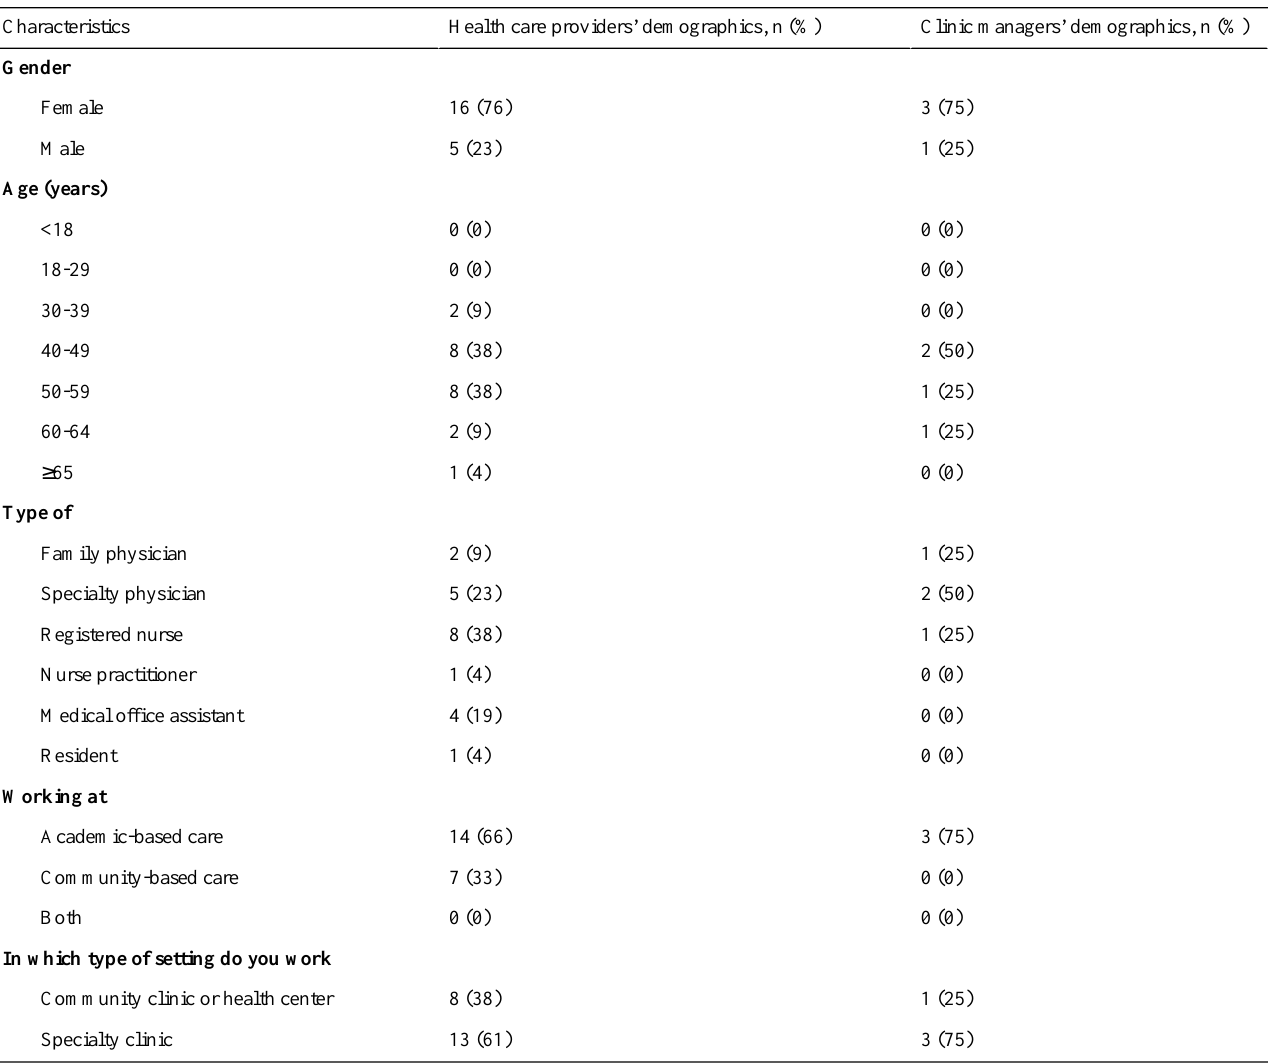
Table 3. Demographic information of the health care providers (n=21) and clinic managers